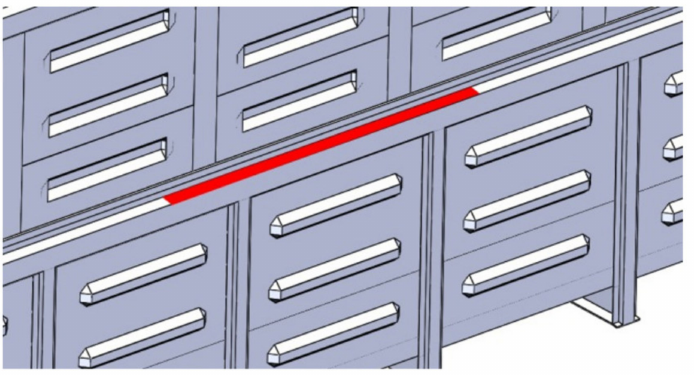
Figure 7. Modelling the contact zone of the grab bucket with the upper strapping of a gondola car.